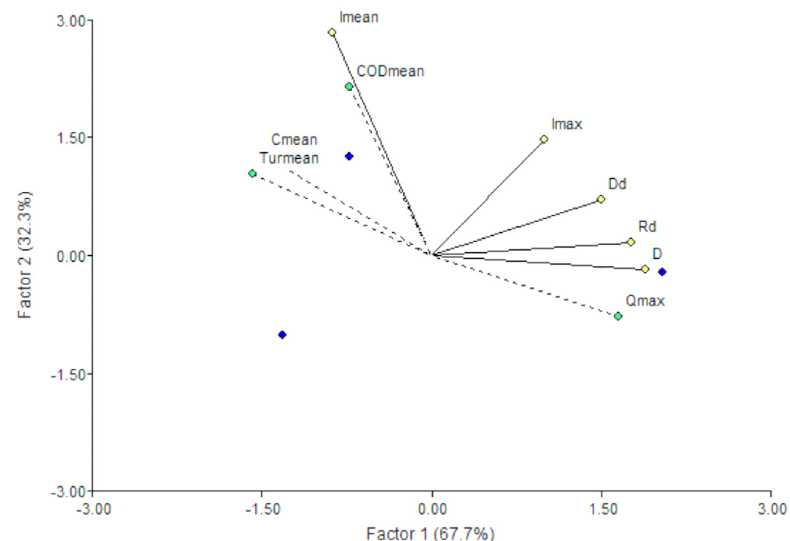
PLS model of the Multifamiliares CSO in the same graph.